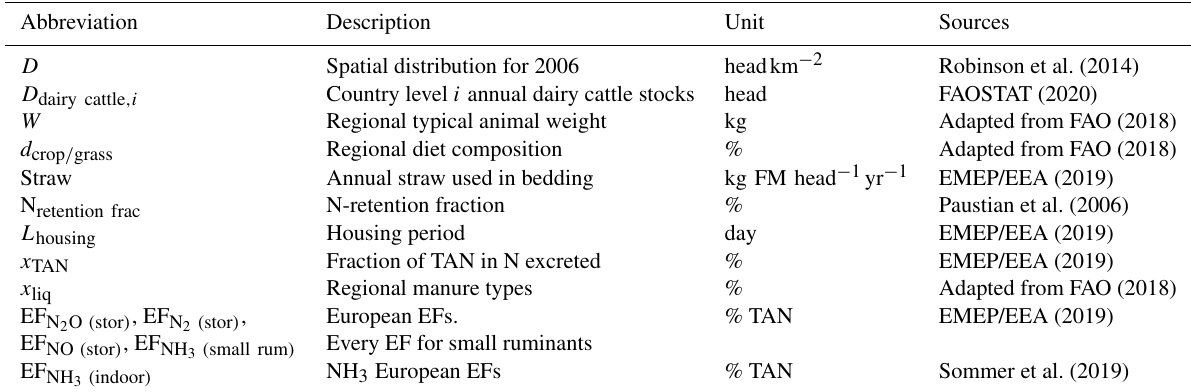
Table 4. Summary of the data sources used in Sects. 2.1 and 2.1 for the calculation of the indoor emissions. All of the data are used for each livestock type a except for the D dairy cattle ,i